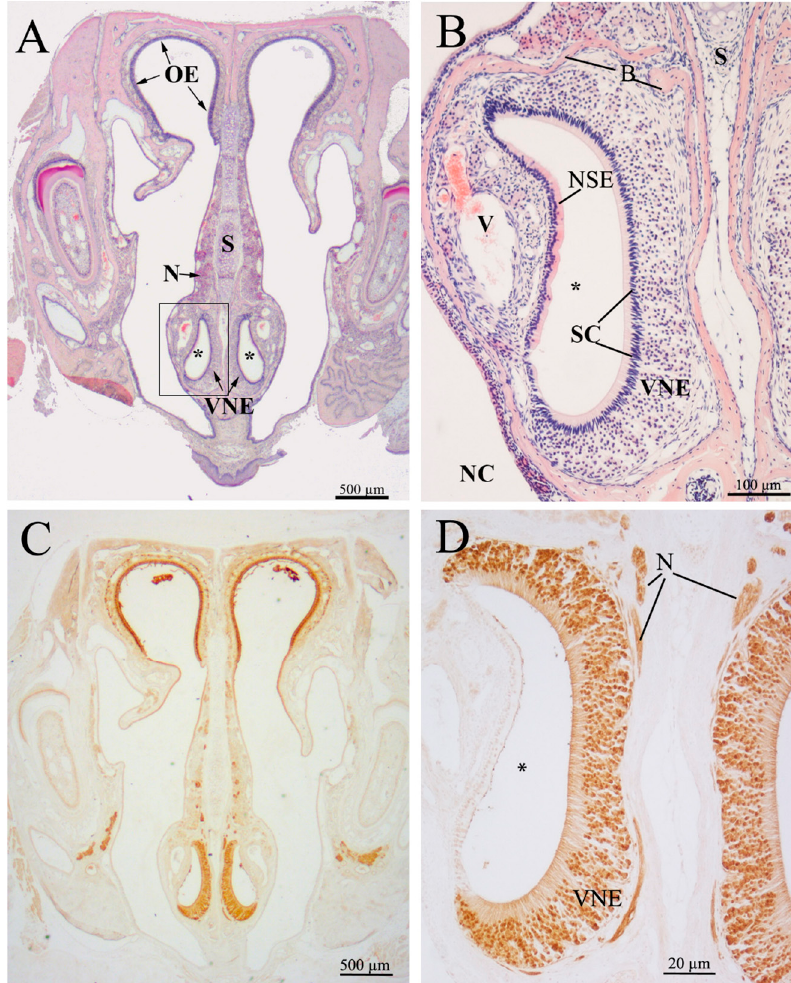
Figure 1. Structural overview of the vomeronasal organ . ( A ) H&E-stained frontal section of the nasal cavity of a Npc1 +/+ mouse, day 57, with the bilateral vomeronasal duct located in the ventral nasal septum. The vomeronasal duct (*) is lined by the receptor-bearing sensory neuroepithelium (VNE). The vomeronasal nerve (N) transfers sensory information along the nasal septum (S) to the accessory olfactory bulb in the telencephalon (not shown). OE, olfactory epithelium; ( B ) minute structure of the vomeronasal duct (*), the VNE, the receptor-free non-sensory epithelium (NSE), and blood vessels (V). S, nasal septum; SC, supporting (sustentacular) cell layer; B, surrounding bone clip; ( C ) immunohistochemical reaction of olfactory marker protein (OMP). OMP identifies olfactory (dorsal) and vomeronasal (ventral) receptor neurons; ( D ) detailed lamination of the pseudostratified VNE. Vomeronasal receptor cells are reactive to OMP; supporting cells (SC) and the opposite, lateral non-sensory epithelial cells are OMP-negative.